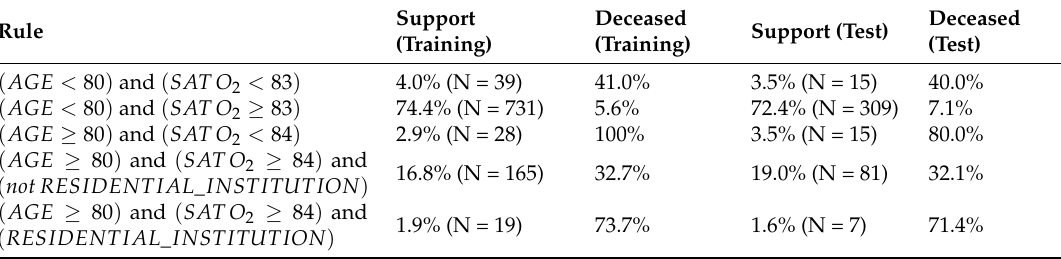
Table 3. Rules extracted from the decision